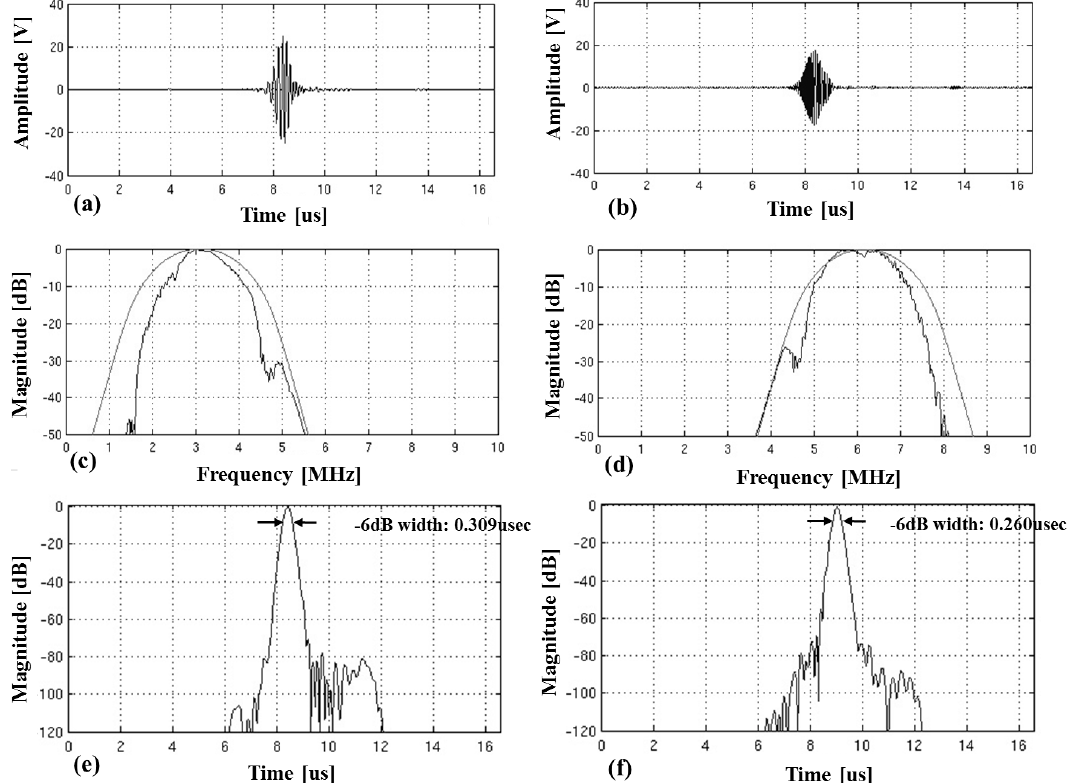
Figure 9. Separation and compression of two chirps received after simultaneously transmitting two orthogonal chirps. Time waveforms showing the results the received signal is correlated with ( a ) c 1 correlator and ( b ) c 2 correlator, corresponding frequency spectrums of ( c ) c 1 correlator (outer line) and correlation output (inner line) and ( d ) c 2 correlator (outer line) and correlation output (inner line), and corresponding envelop signals in dB scale of ( e ) c 1 correlation output and ( f ) c 2 correlation output.